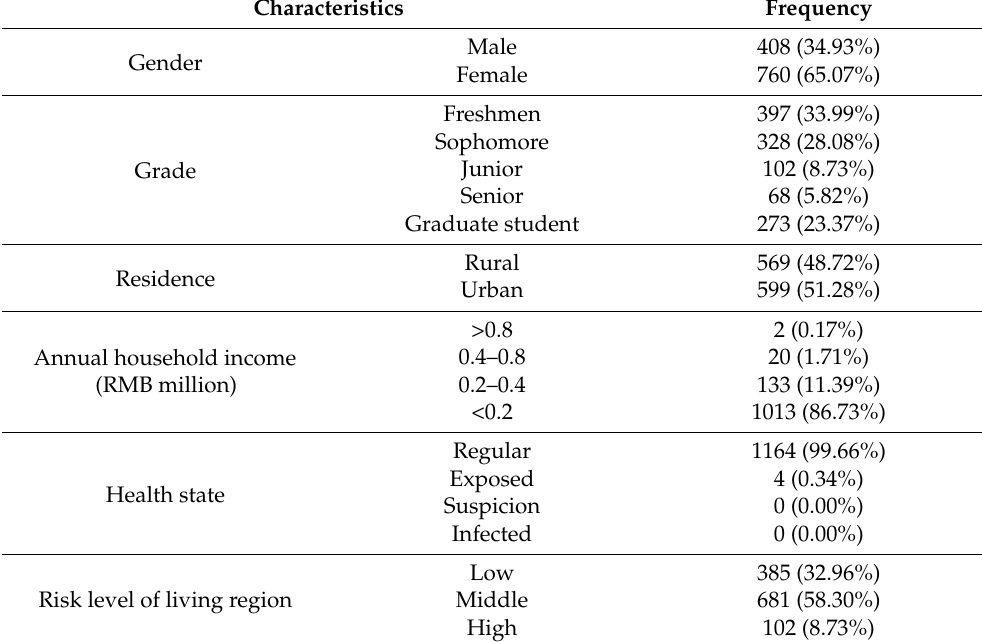
Table 1. Demographic characteristics of participants ( n =